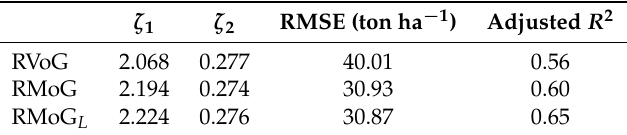
Table 4. Coefficients of the fitted power series (within 95% confidence interval).